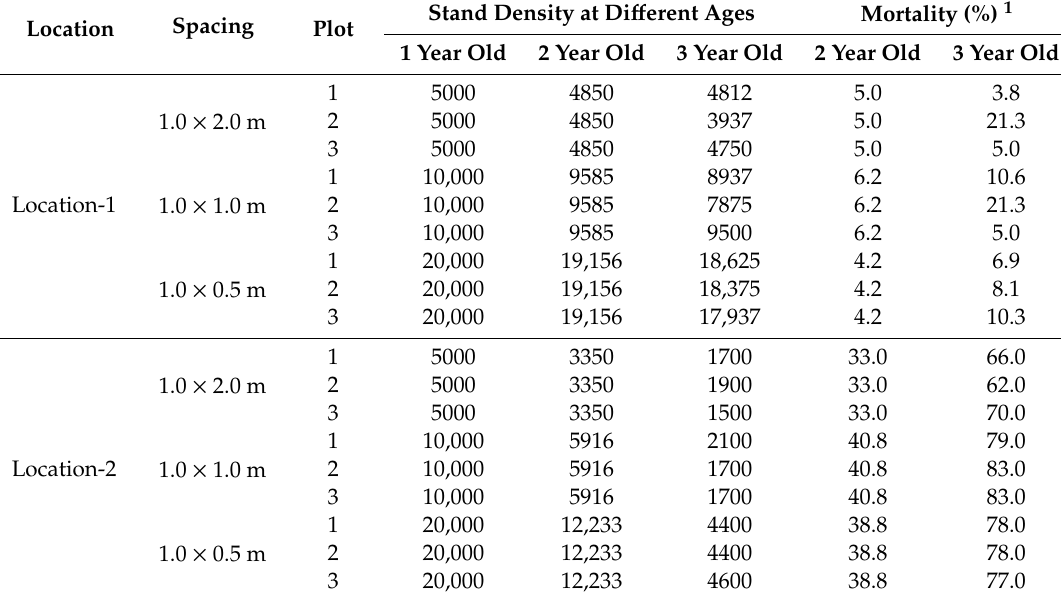
Table 3. Remaining trees and mortality in short rotation Gmelina arborea plantations in two di ff erent locations in Costa